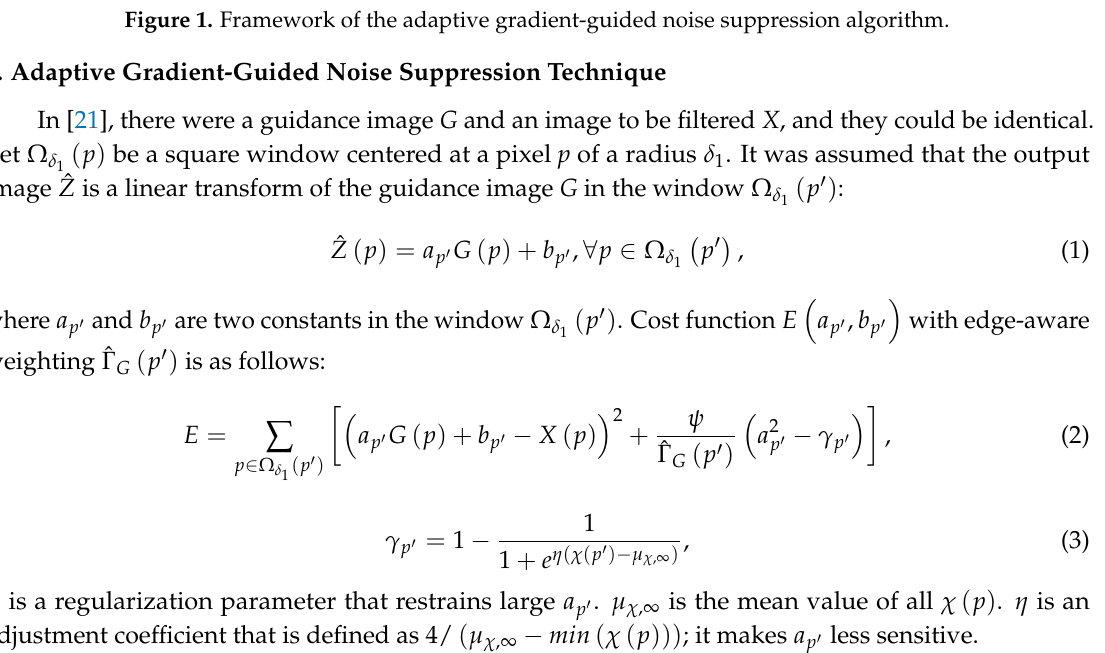
Figure 1. Framework of the adaptive gradient-guided noise suppression